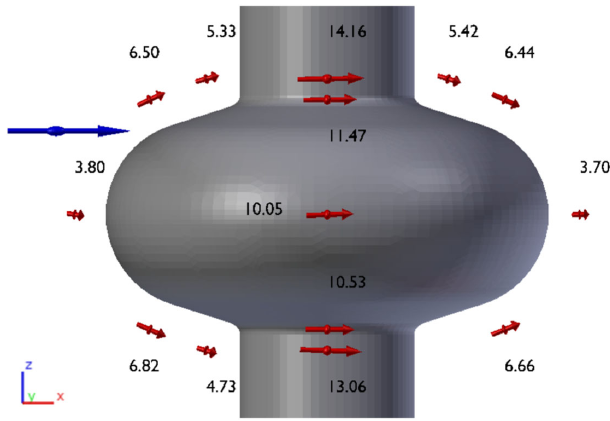
FIG. 7. Measured flux distribution for a field applied in φ ¼ 0 ° ( α ¼ 0 °) after the cavity is superconducting, this state mimics full expulsion. The numbers next to the arrows show the magnitude of the magnetic flux density in μ T. The blue arrow indicates the direction of the applied field, but it is not to